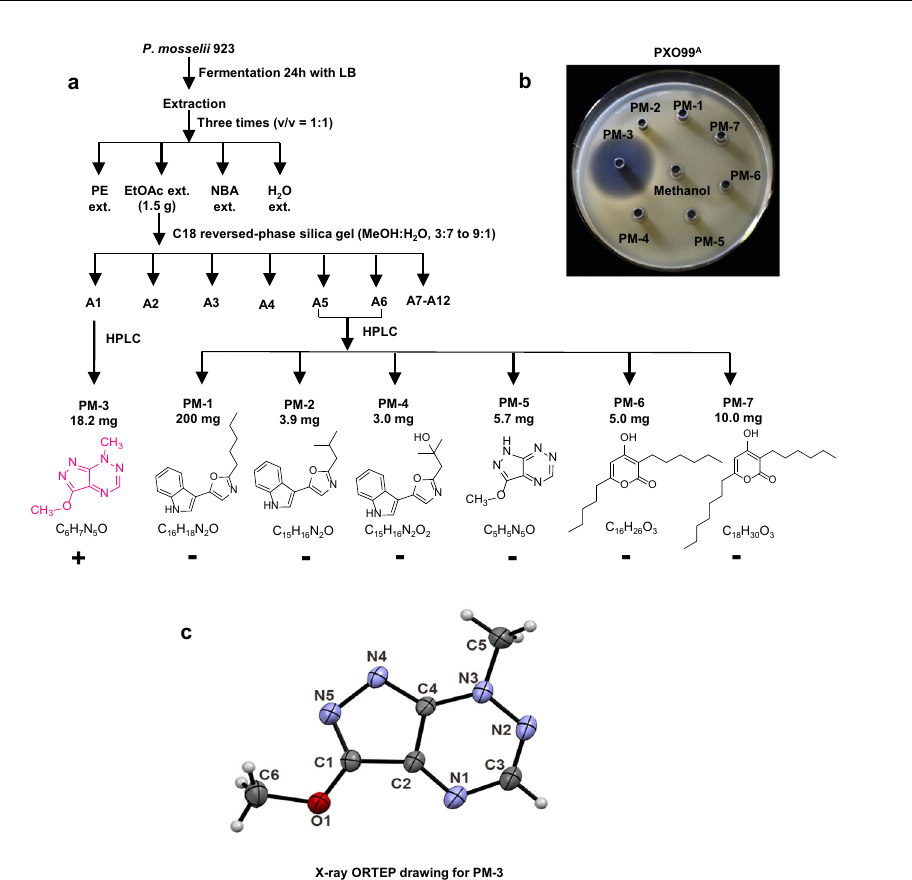
Fig. 2 | Extraction and puri fi cation of PM-3 (pseudoiodinine). a Flow chart for extraction and isolation from the strain 923 compounds that inhibited PXO99 A . Abbreviations and structures are as follows: PE, petroleum ether; EtOAc, ethyl